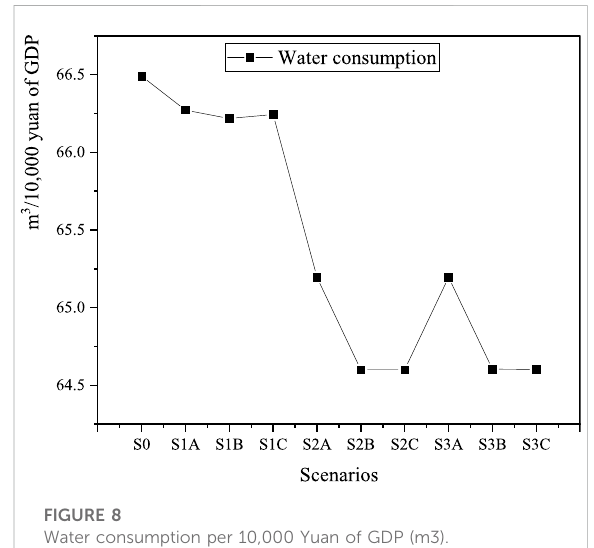
FIGURE 8 Water consumption per 10,000 Yuan of GDP